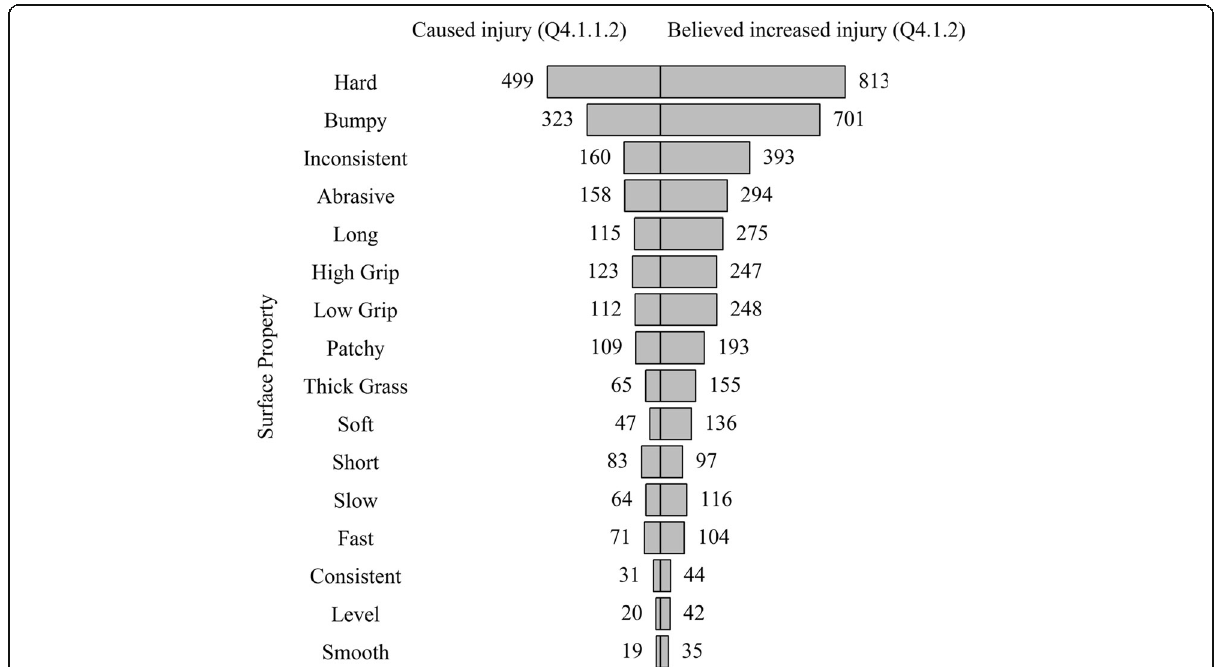
Fig. 7 Horizontal pyramid plot of surface properties believed to have contributed to an injury (Q4.1.1.2) and believed to increase the risk of injury (Q4.1.2) ordered by total number of responses for both questions